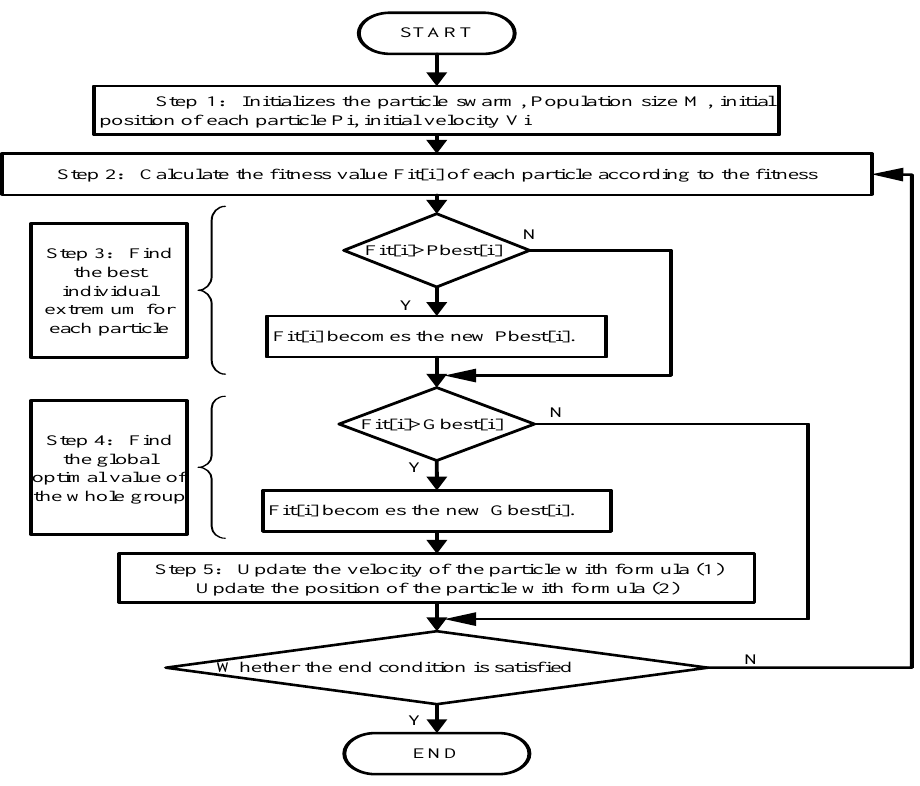
Figure 3. Flowchart of the PSO algorithm.